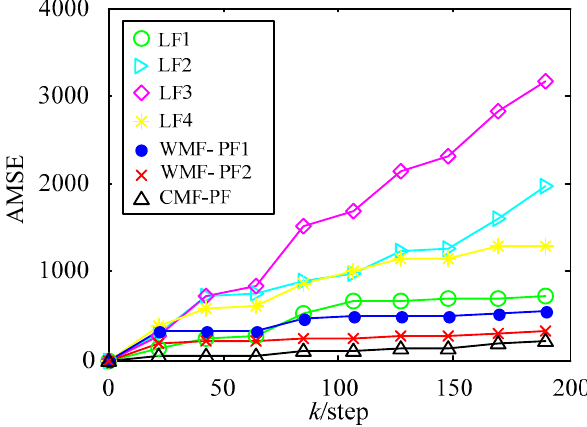
Figure 4. AMSE curves of local PFs, WMF-PF1, WMF-PF2, and CMF-PF.